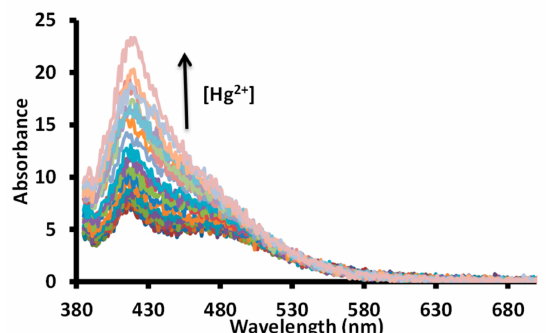
Figure 12. Change in fluorescence spectra of a solution of receptor 1 in water (pH = 7.6, 1.0 mM HEPES) upon incremental addition of acetate salts of mercuric ions. The up arrow indicate an increase in intensity with an increase in mercuric ion concentration; [ 1 ] = 20 µ M; [Hg 2 + ] = 0–0.67 µ